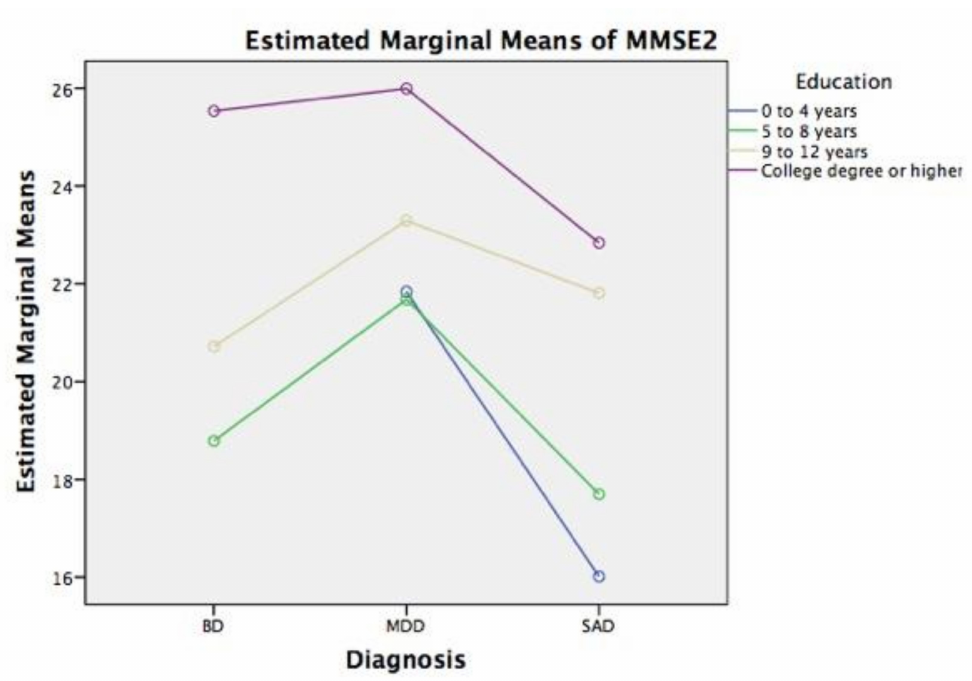
Figure 3. Estimated marginal means of MMSE-2 scores across the diagnosis and education categories, adjusting by smoking, diet, and gender, as